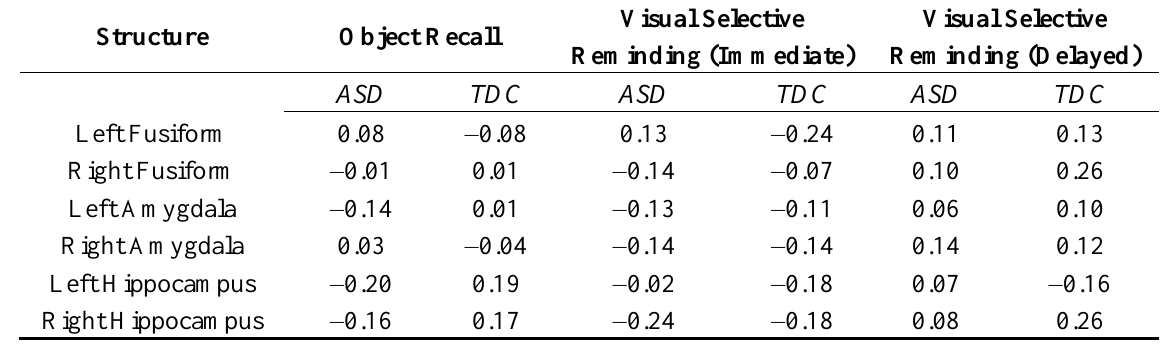
Table 5. Partial correlations between facial memory ROI volumes and TOMAL performance—controlling for TICV and